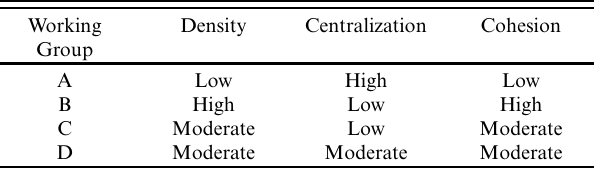
Table 1 . Assessment of current working group density, centralization, and